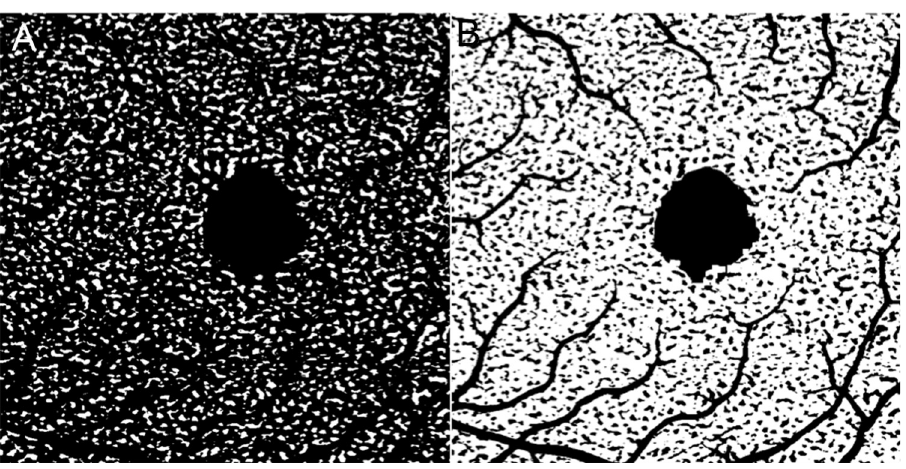
Fig 1. Binarized OCTA images of the choriocapillaris for quantitative image analysis. A. The image used for analyzing the flow voids without flow signals; the flow voids are white, and the vessels are black. B. The image used for analyzing the vessels; the vessels are white, and the flow voids are black. The image on the “left” is the inverted image. However, the major vessels and FAZ appear black as they are excluded from this analysis.